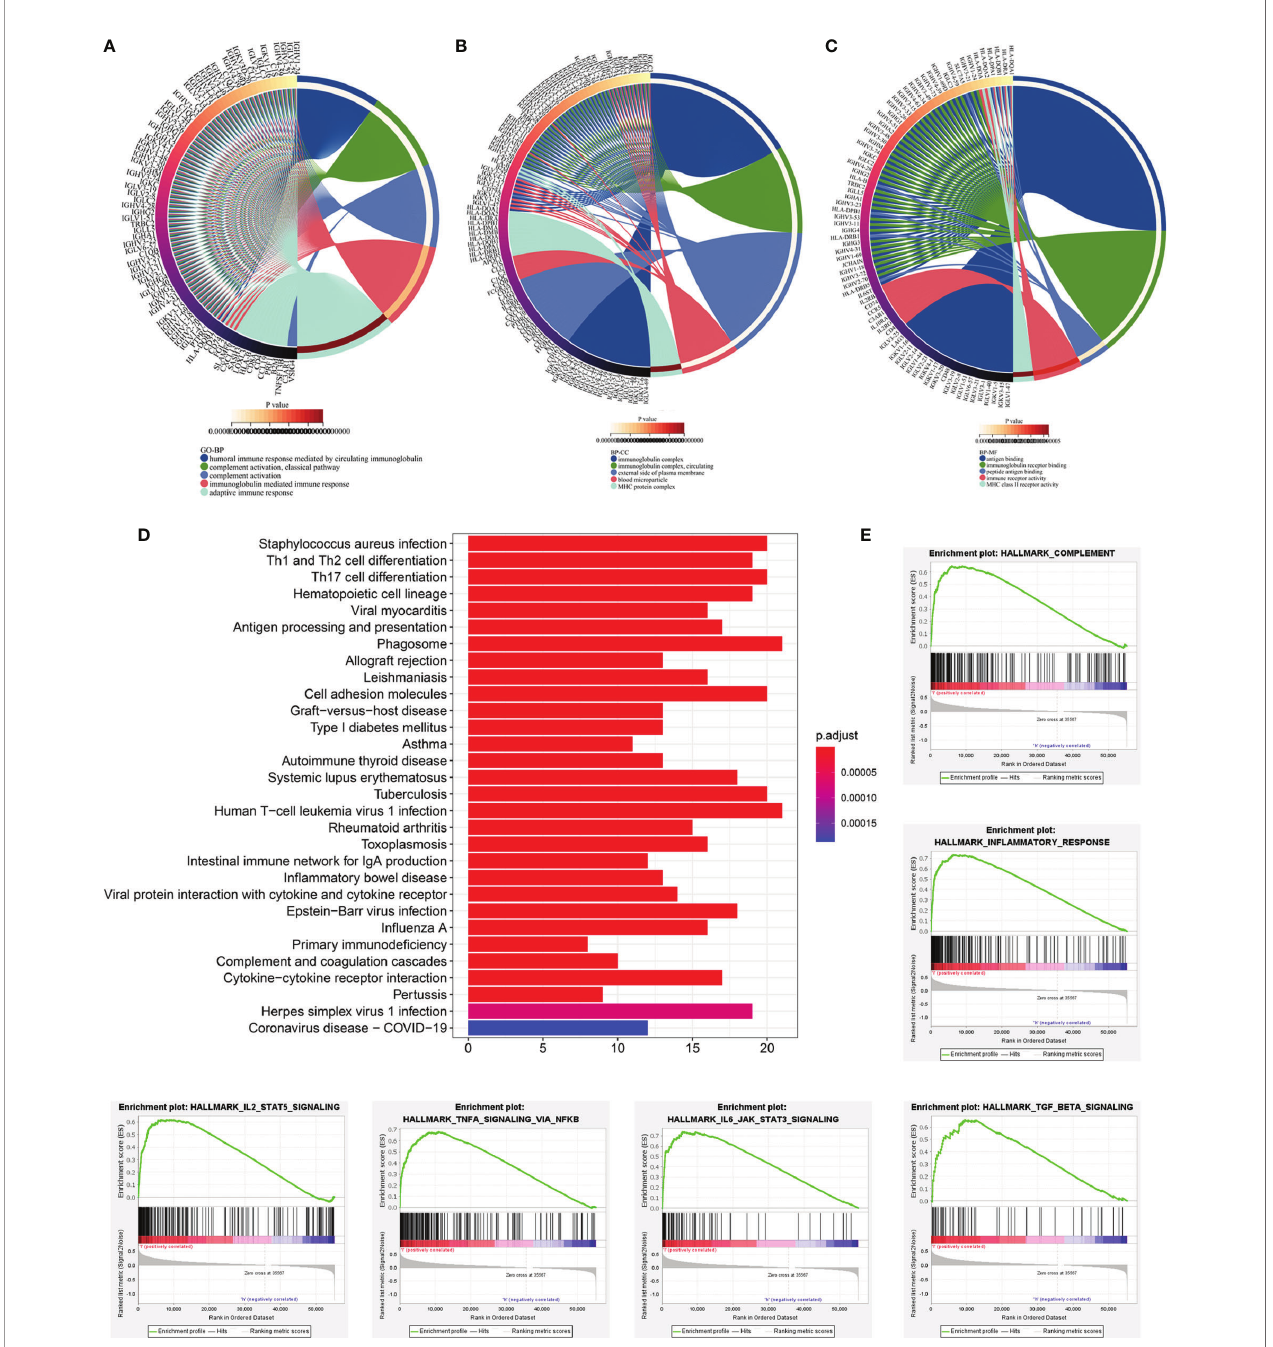
FIGURE 8 | Functional enrichment analyses of DEGs between low ‐ and high-risk subgroups based on LRG signature. Go annotation terms of DEGs between low ‐ and high-risk subgroups for biological process (A) , cellular components (B) , and molecular functions (C) . (D) KEGG enrichment analysis for DEGs between low ‐ and high-risk subgroups. (E) GSEA fi